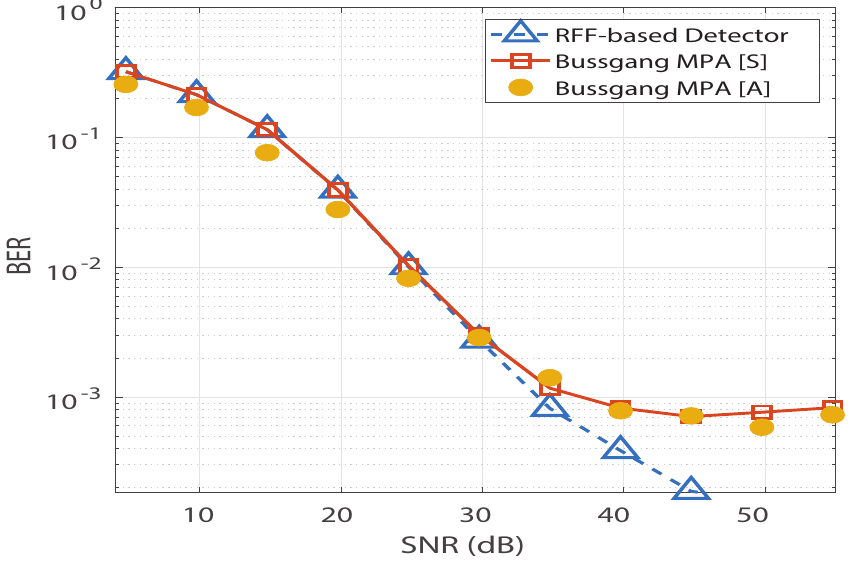
Figure 6. BER vs. SNR validation for the Bussgang-based detector for a Nakagami- m channel with m =